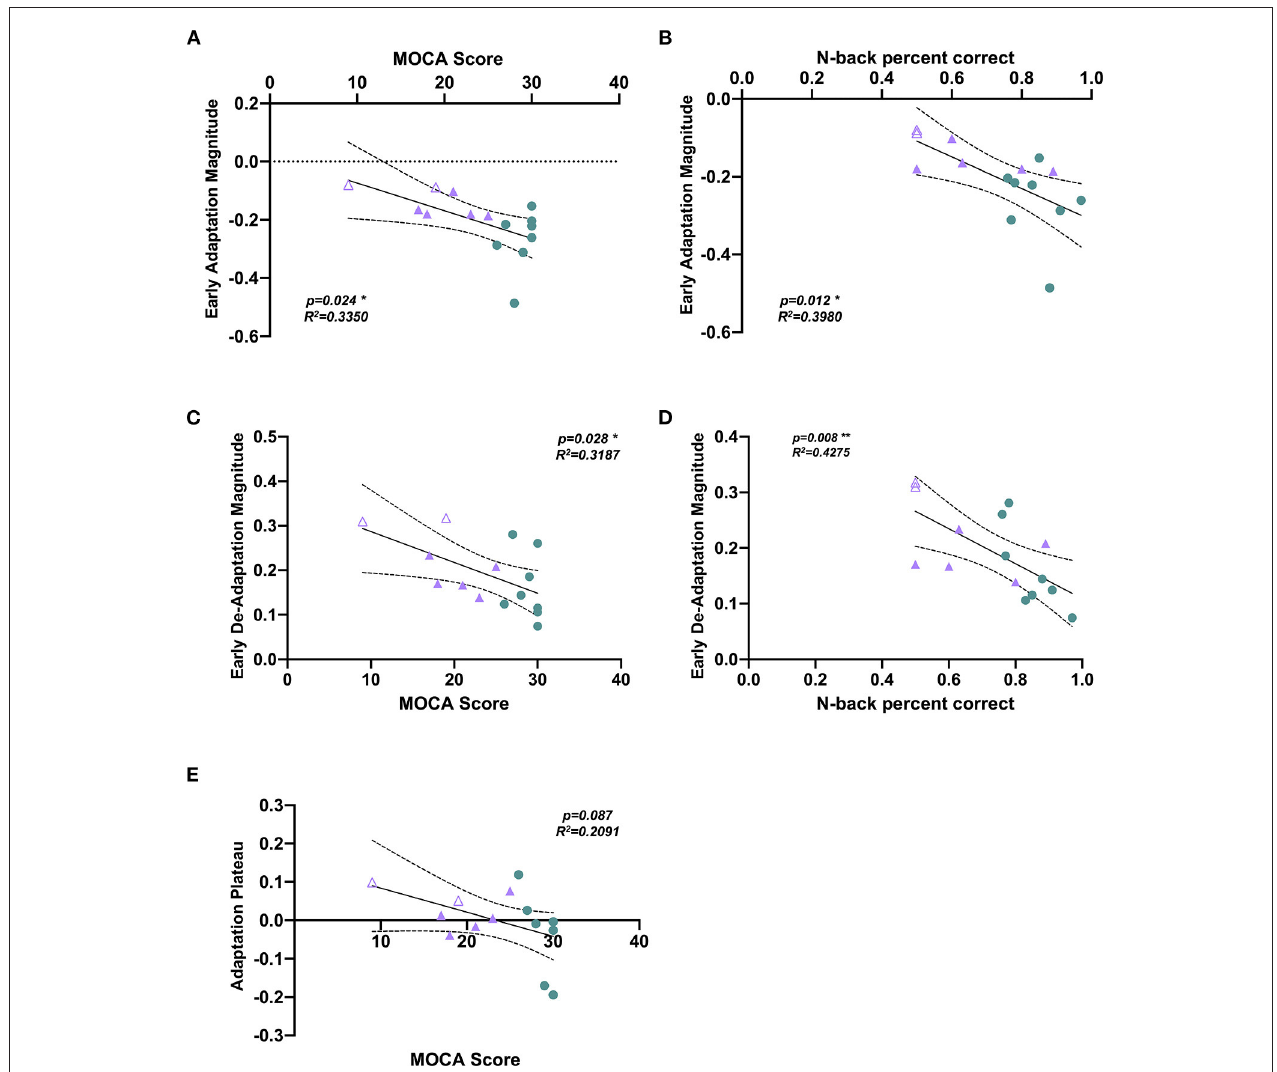
FIGURE 3 | Scatterplots showing correlations between cognitive impairment measures and split-belt walking adaptation measures. A significant Pearson’s correlation was observed between (A) MOCA score and early adaptation magnitude ( p = 0.024, R 2 = 0.3350), with a higher MOCA score correlating to a greater magnitude of adaptation. (B) n-back correction rate and early adaptation magnitude ( p = 0.012, R 2 = 0.3980), with a higher n-back accuracy correlating to a greater magnitude of adaptation. (C) MOCA score and early de-adaptation magnitude ( p = 0.024, R 2 = 0.3350), with a higher MOCA score correlating to a lesser magnitude of de-adaptation. (D) n-back correction rate and early de-adaptation magnitude ( p = 0.008, R 2 = 0.4275), with a higher n-back accuracy correlating to a lesser magnitude of de-adaptation. (E) Correlation analysis between MOCA score and adaptation plateau ( p = 0.087, R 2 = 0.2091). Note that the HOA participant data are shown in green circles, MCI participant data in purple filled triangles, AD participant in purple unfilled triangles. * p < 0.05, ** p <